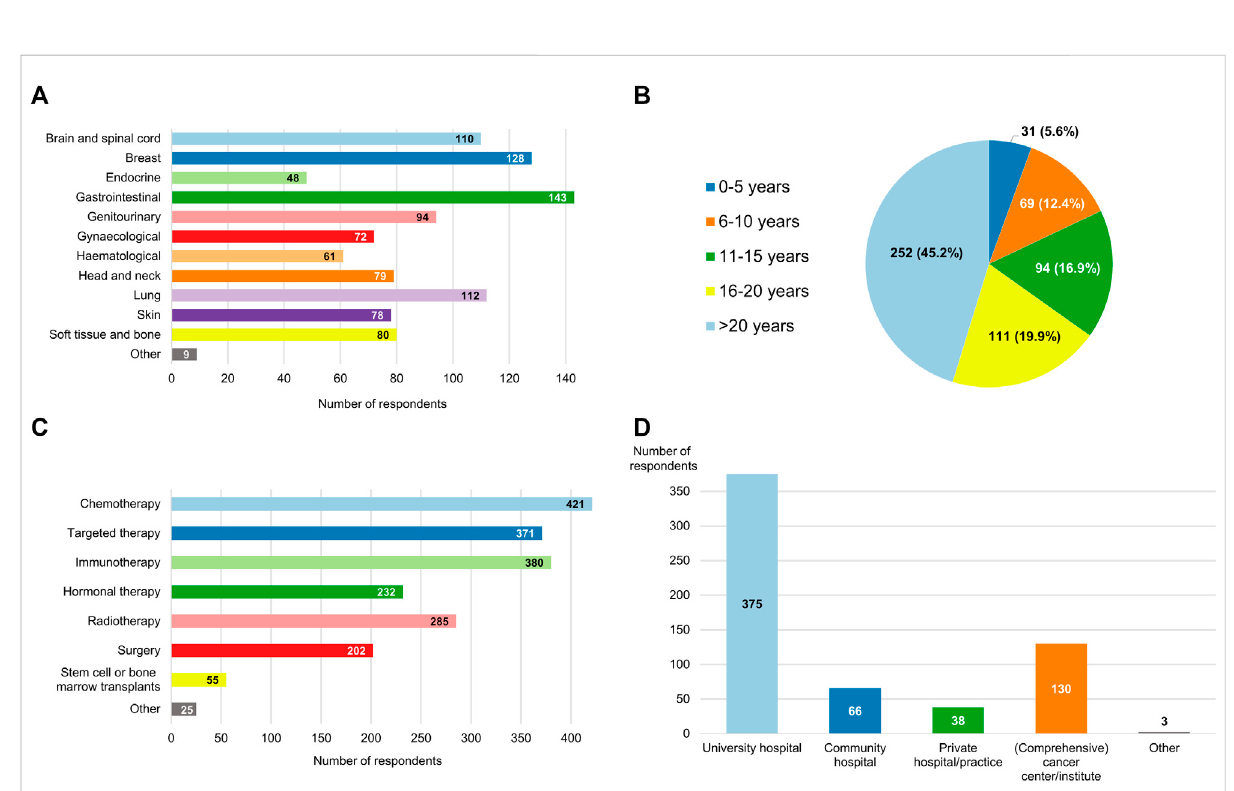
FIGURE 2 Breakdown of the respondents by (A) oncological specialty; (B) experience, expressed in years active as a clinician; (C) type of anticancer treatments they administer to their patients; and (D) type of hospital or institution that employs them. The aggregate numbers reported for (A , C , D) exceed the total number of participants because multiple response options could be selected for these